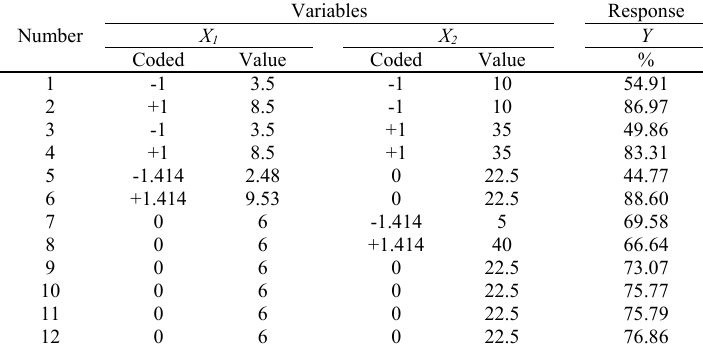
Table 5: The design values, experimental variables and observed responses